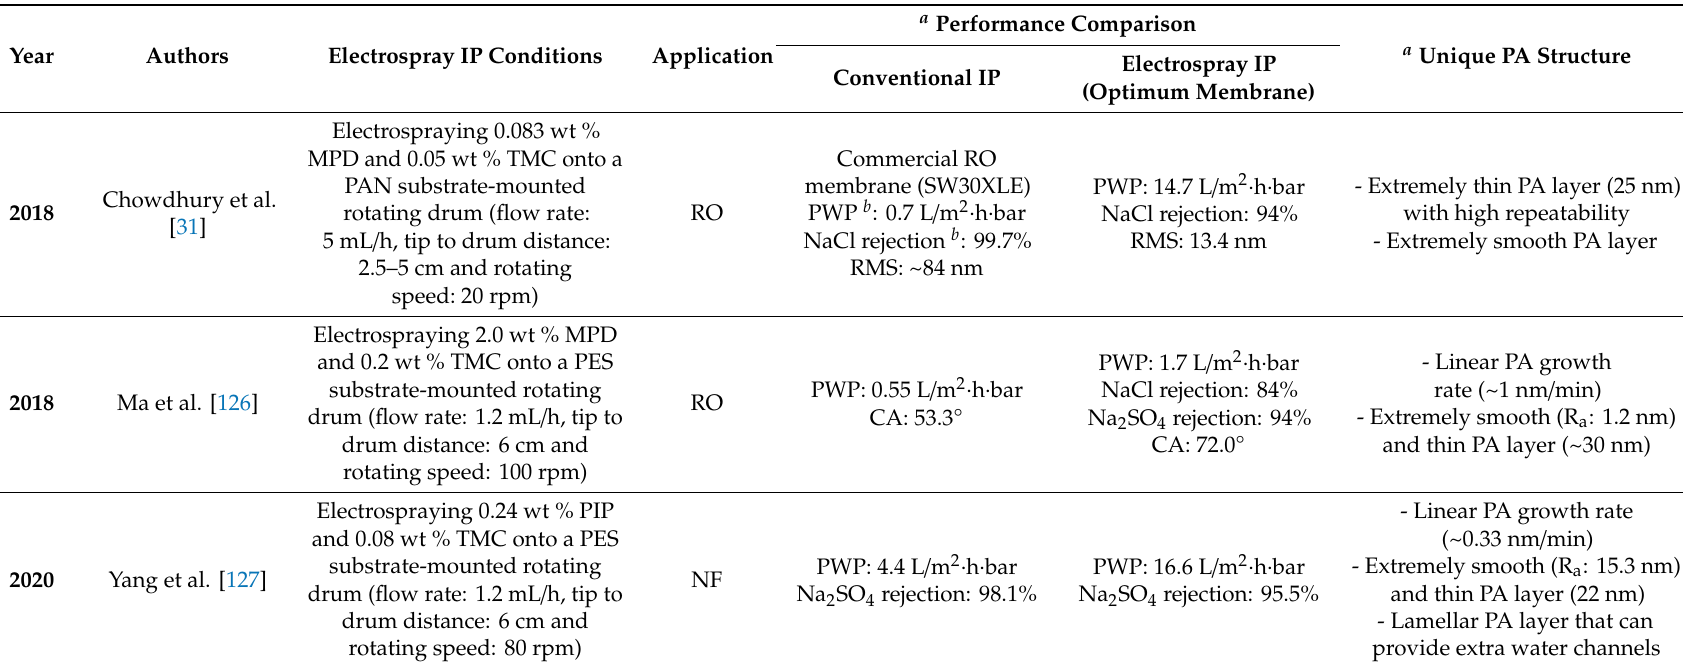
Table 6. Comparison of TFC membranes fabricated by using conventional and electrospray